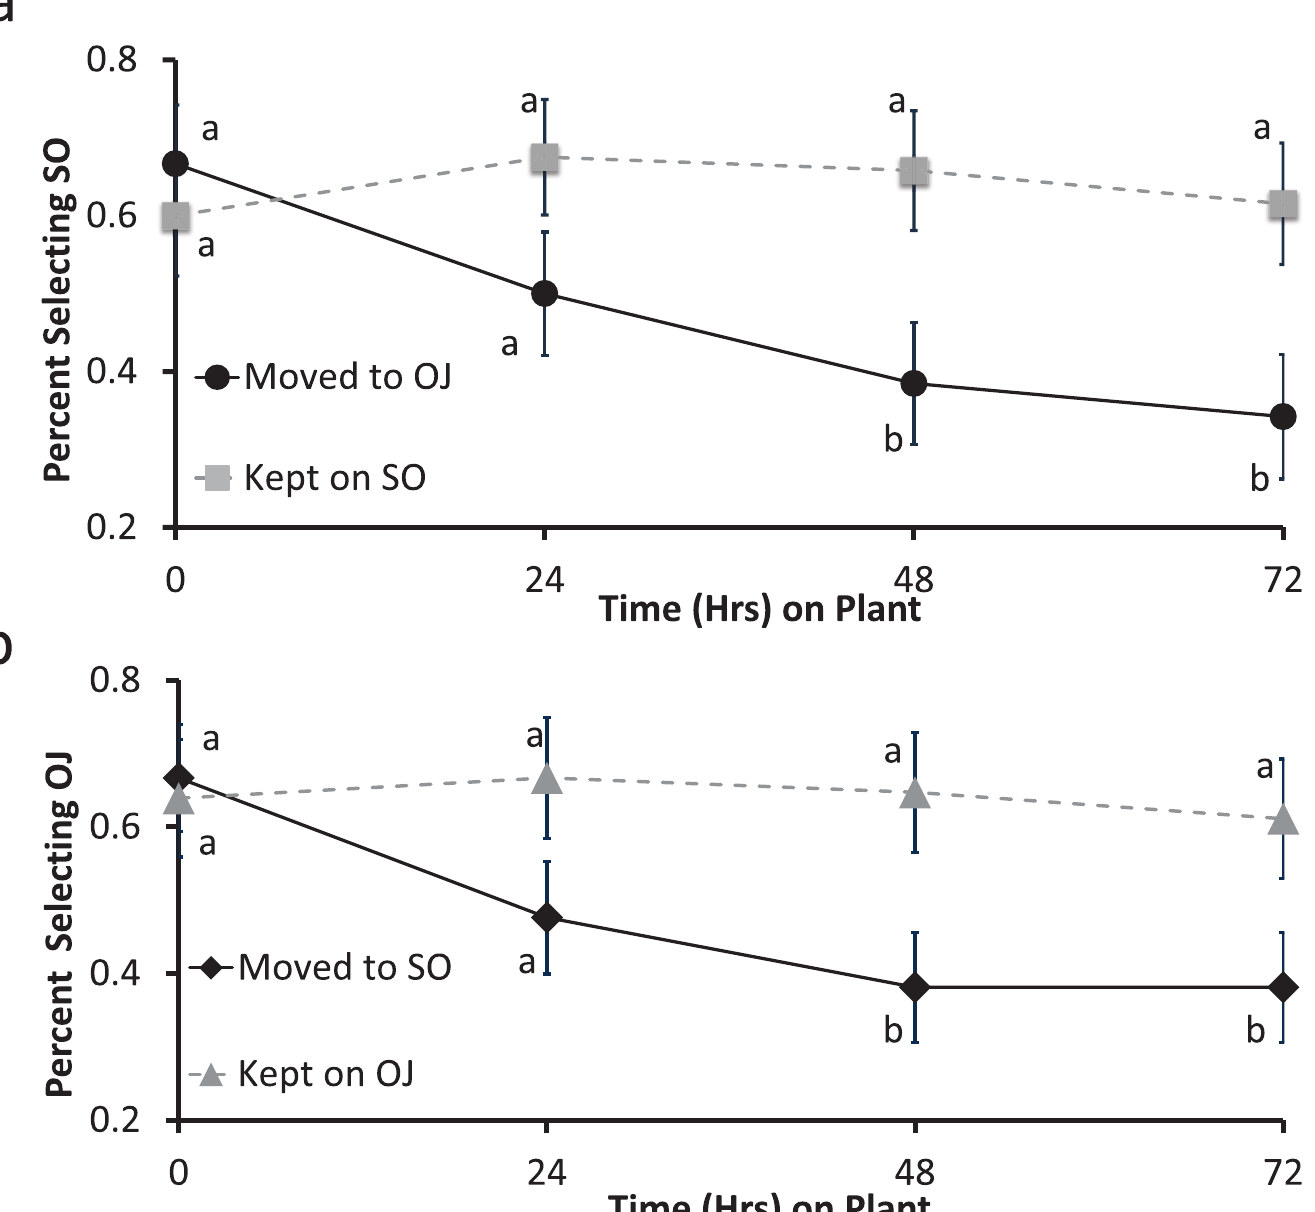
Fig 3. Experience dependent host plant preference. Shifts in preference after short-term adult experience feeding on the alternative host plant species. The labels “ Kept on SO ” (sour orange) or “ Kept on OJ ” (orange jasmine) represent the control groups — D . citri maintained on a single host plant species for the duration of the study. The experimental groups are labeled as “ Moved to SO ” or “ Moved to OJ. ” Significant differences between groups at each time point are indicated by different letters ( χ 2 test, α (cid:1)